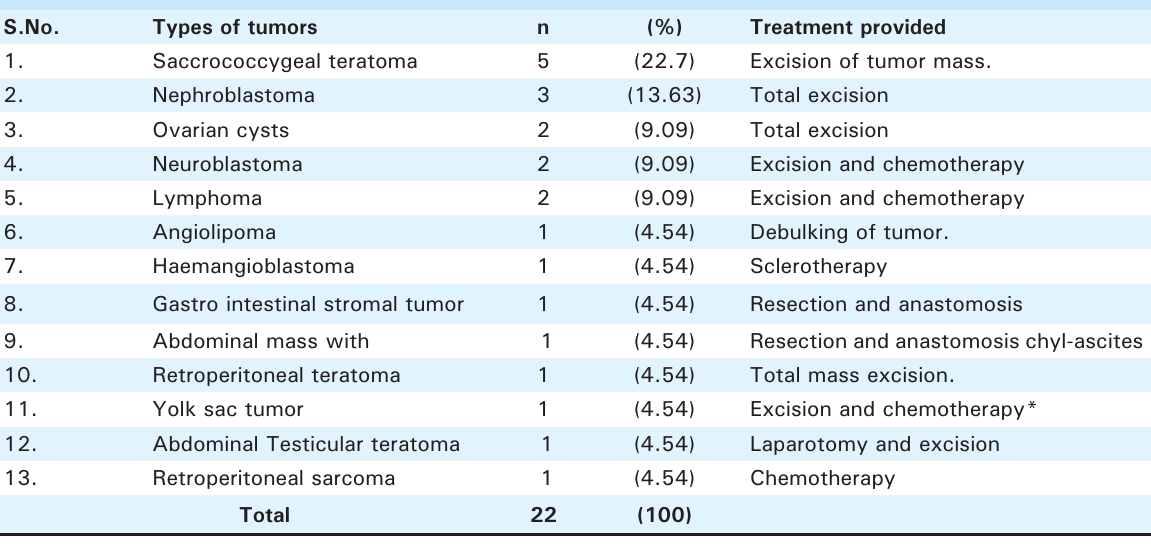
Table 2. The patterns of tumors and their management are shown in Types of Pediatric Tumors. S.No.